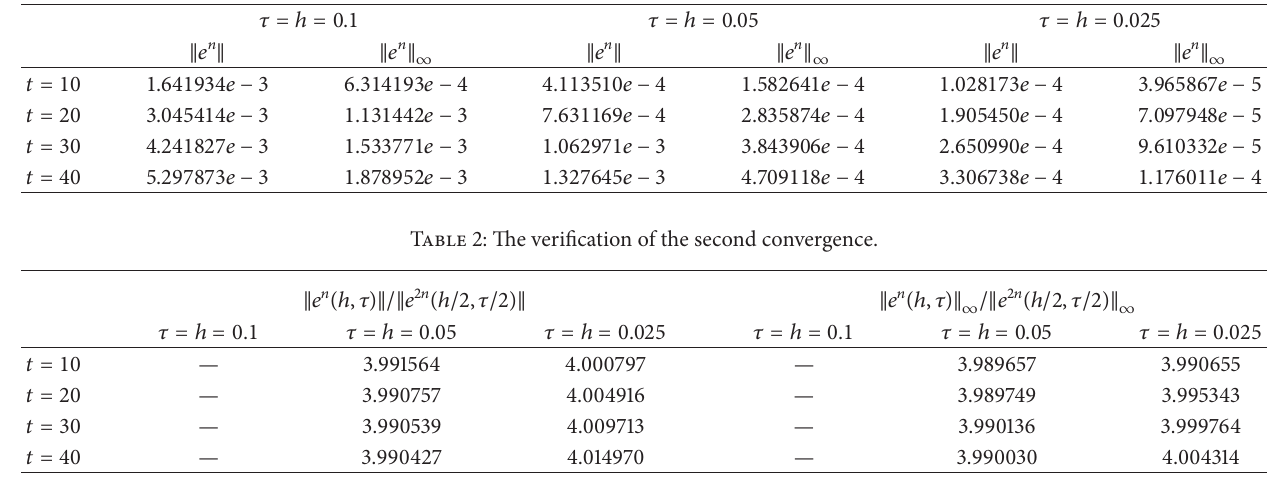
Table 1: The error at various time steps.